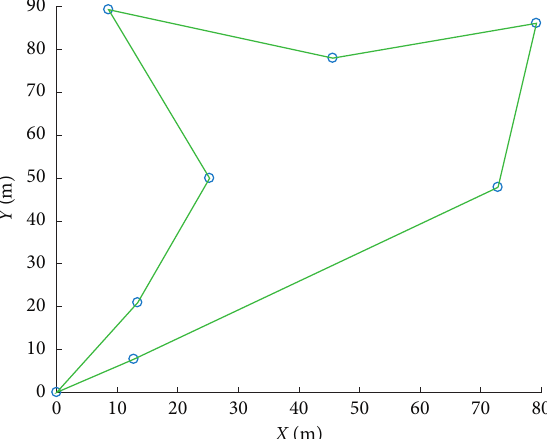
Figure 10: Planned trajectory at the beginning of the second